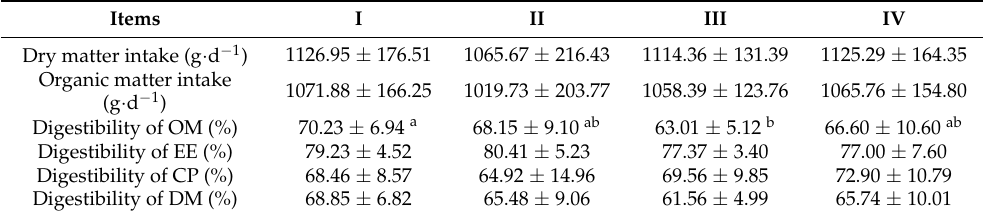
Table 5. Effects of dietary supplementation with different inclusion of SMS-MP on feed intake and apparent digestibility of growing sika deer.